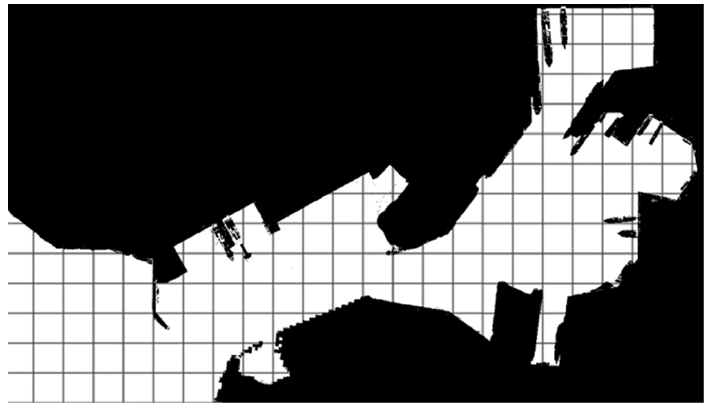
Figure 8. Simulation environment used for the comparative evaluation.